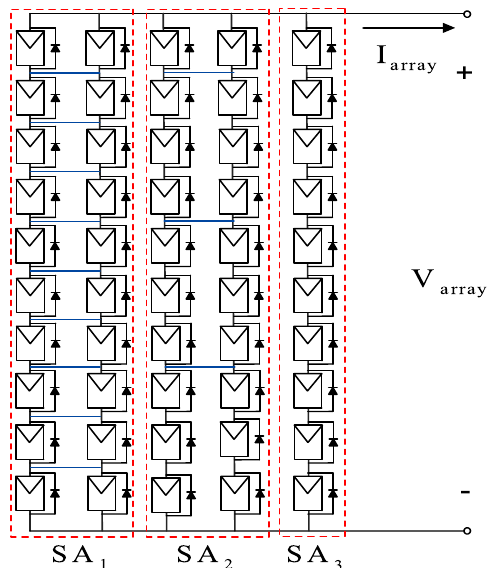
Figure 9. The irregular PV array used in